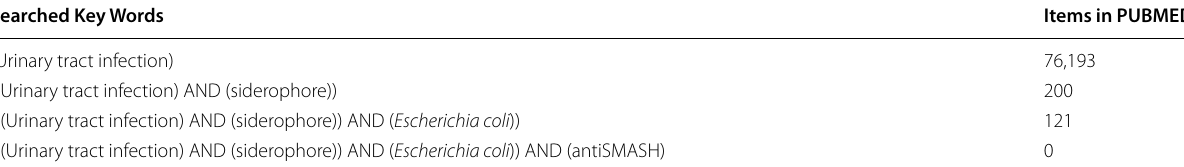
Table 1 The searched key words of the study (04.04.2022)